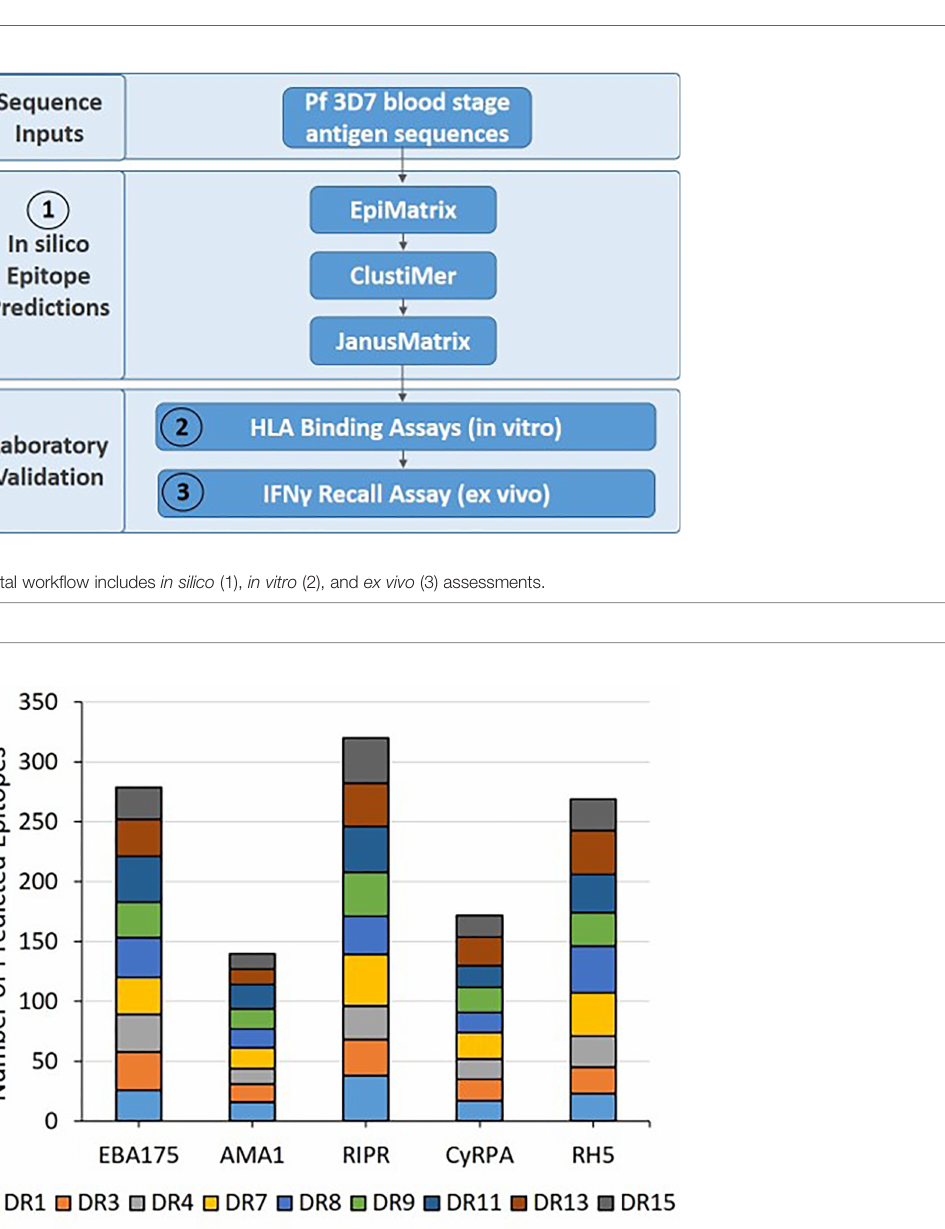
FIGURE 2 | The predicted class II epitopes for the fi ve Pf blood stage proteins are representative of all nine HLA-DRB1 alleles in the panel.